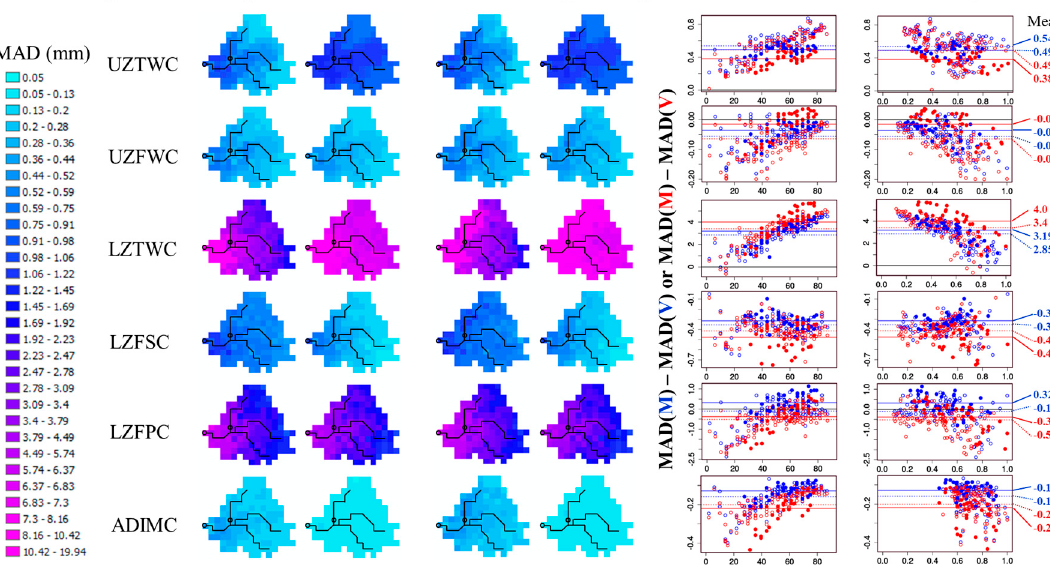
Figure 5. Mean absolute difference (MAD) of a priori and updated SAC-states at the begging ( k = K- L ; top panel) or end ( k = K ; bottom panel) of the assimilation window where the model is applied as a strong-constraint to the assimilation problem.